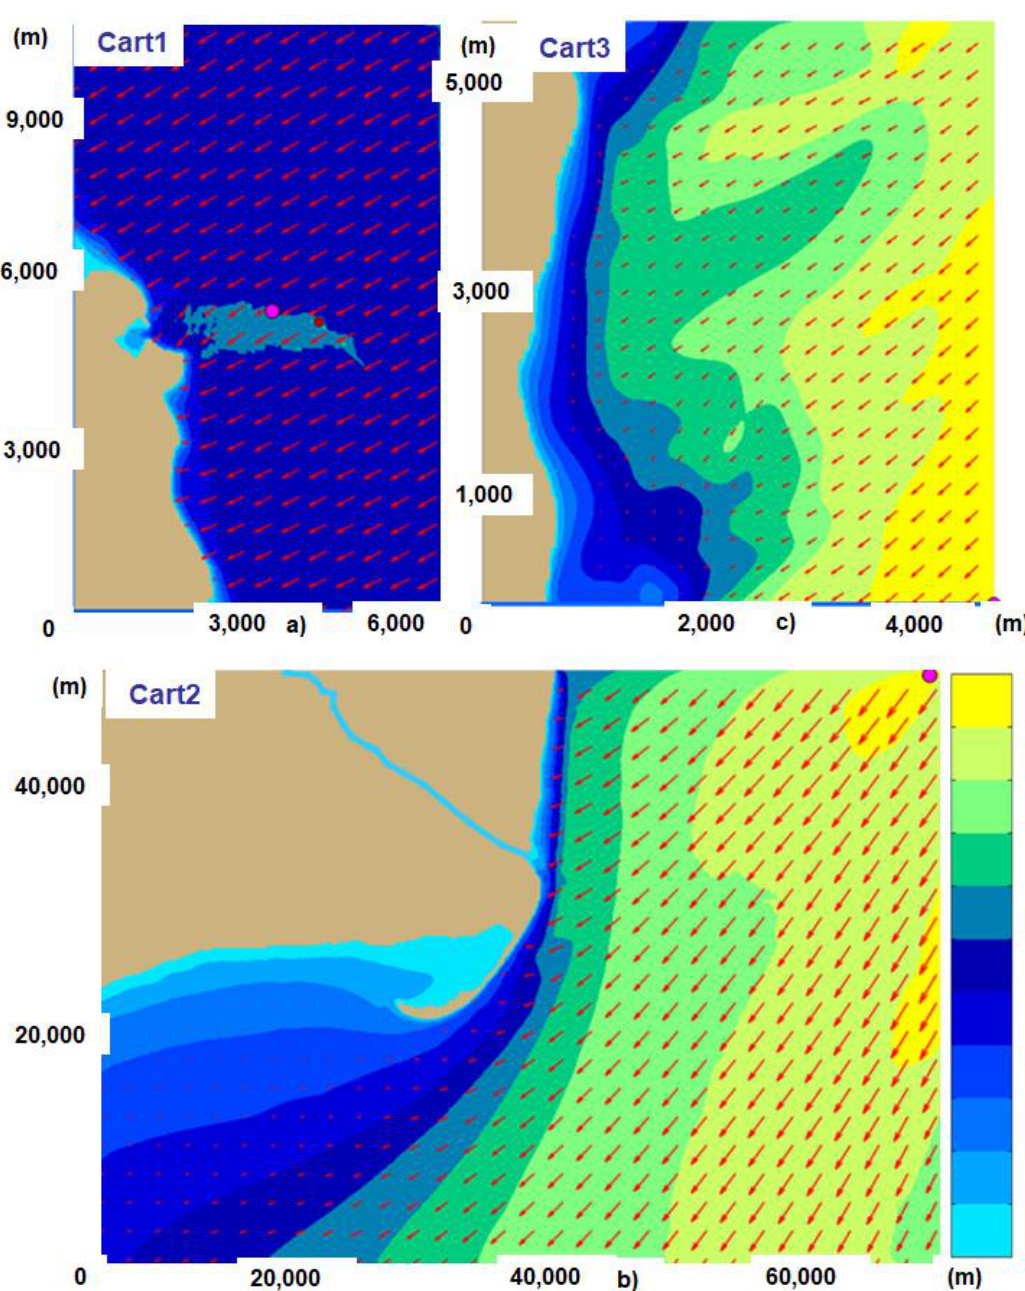
Figure 9. Wave power scalar fields and energy transport vectors (represented by red arrows) in the high resolution Cartesian domains defined: ( a ) Cart1—Sulina bar, average to high wave energy situation corresponding to the time frame 8 November 2017; ( b ) Cart2—Sacalin Peninsula, high wave conditions, time frame 28 November 2017. ( c ) Cart3—Mangalia nearshore, high wave conditions, time frame 18 December 2017.